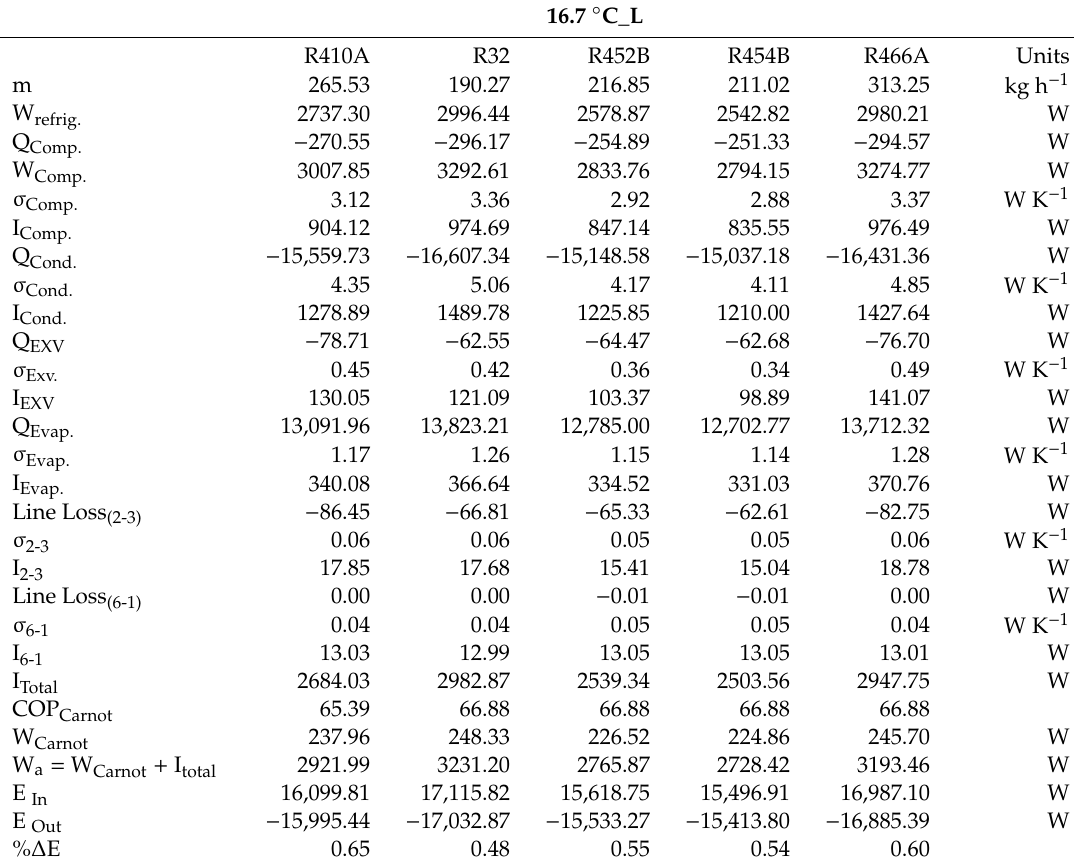
Table 8. Thermal and mechanical energy exchanges from the HPDM model and application of Equations (8)–(11), at 16.7 ◦ C ambient